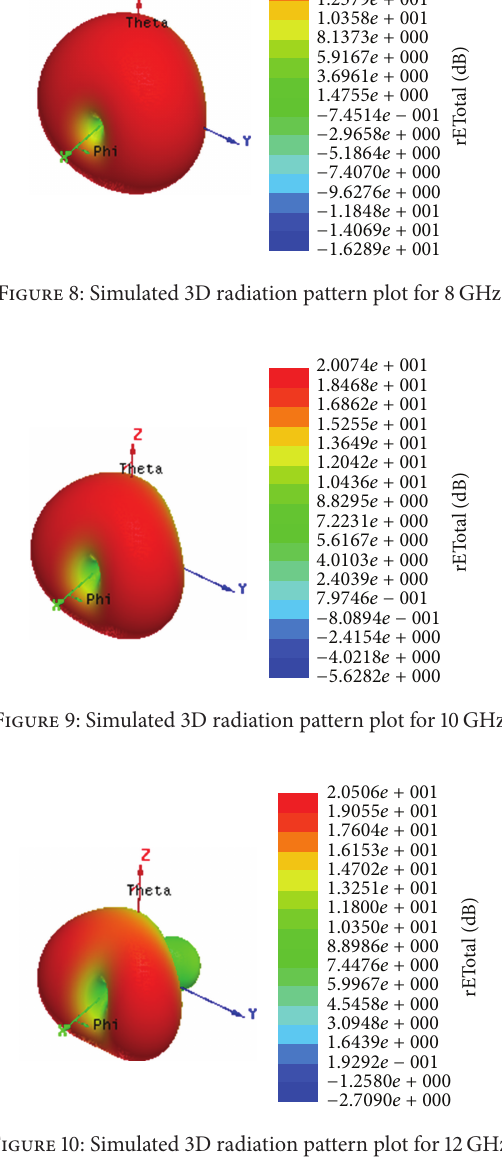
Figure 6: Vector surface current plot for FR4 antenna at 9 GHz.